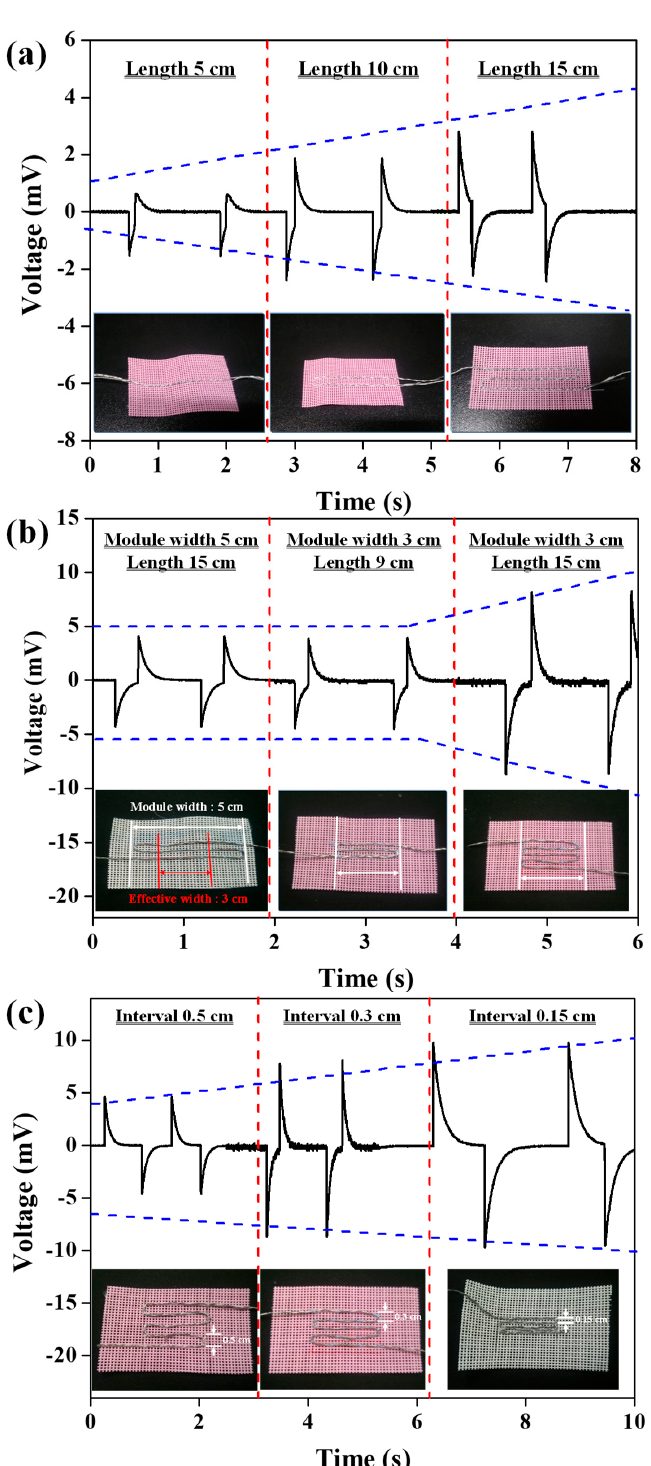
Figure 2. Output voltages according to the ( a ) total length, ( b ) effective area, ( c ) and stitching interval of core-shell piezoelectric yarns during bending tests.